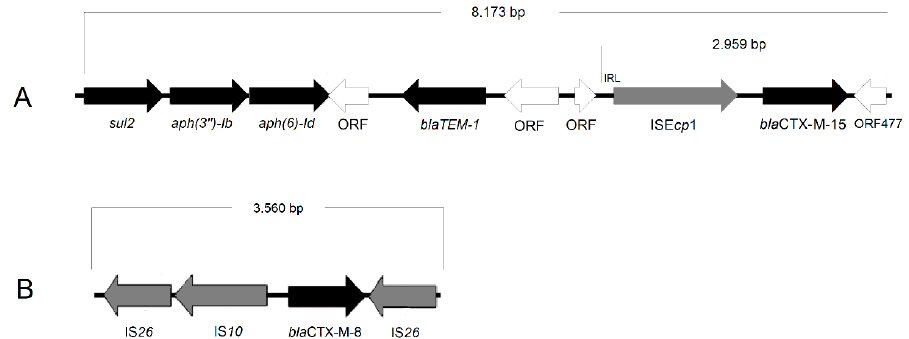
Figure 2. Genetic environment of bla CTX-M-15 ( A ) and bla CTX-M-8 ( B ) in ESBL-producing isolates. Black arrows indicate resistance genes, gray arrows indicate genes related to mobile elements, and white arrows indicate open read frames (ORFs) (bp = base pairs).